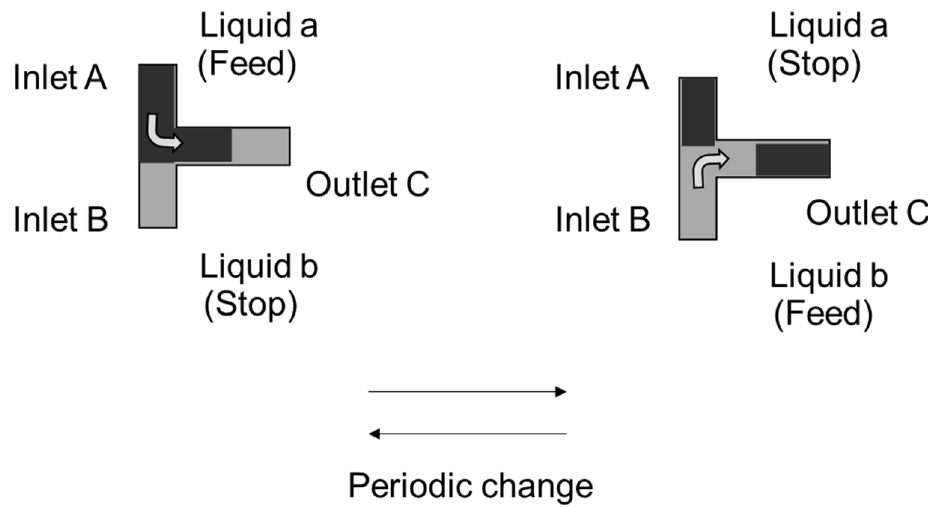
Figure 1. Concept of mechanical generation of slug flow.